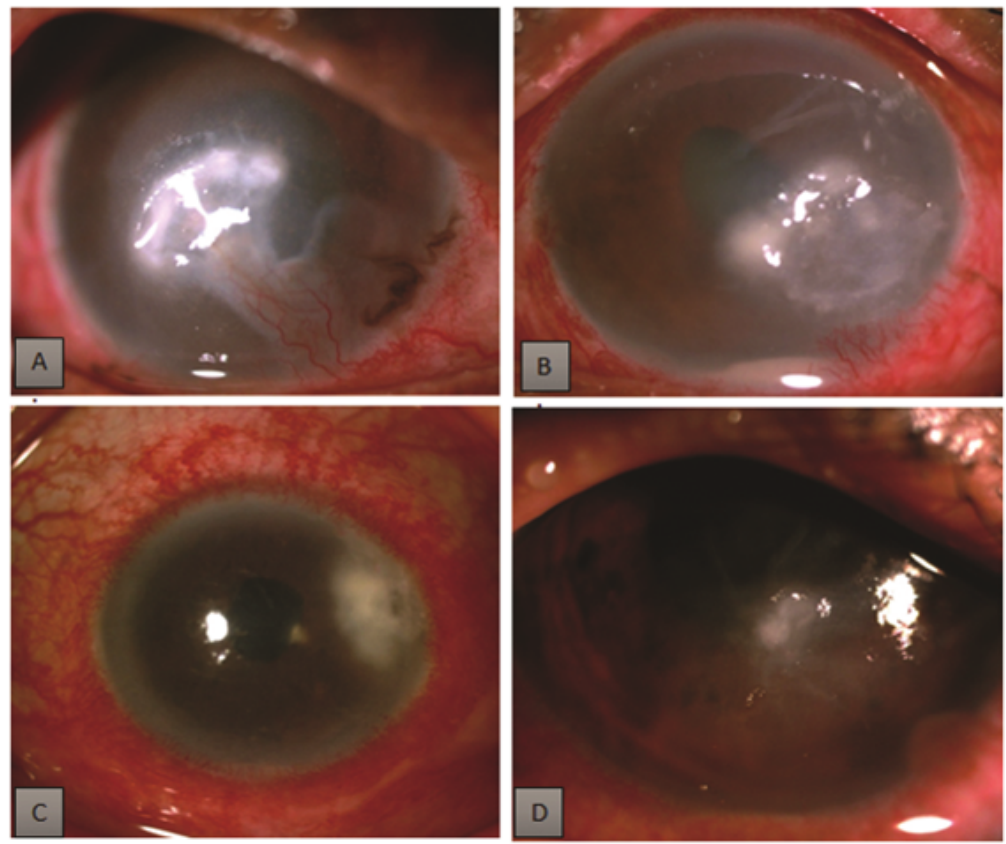
Figure 1. Nontubercular mycobacterial keratitis. (A) After trauma with vegetative matter showing infiltrate with vascularization. (B) Dry-looking infiltrate mimicking fungal infection with hypopyon which was diagnosed as NTM on repeat scraping. (C) Dense infiltrate after cataract surgery. (D) Paracentral infiltrate with severe stromal edema.